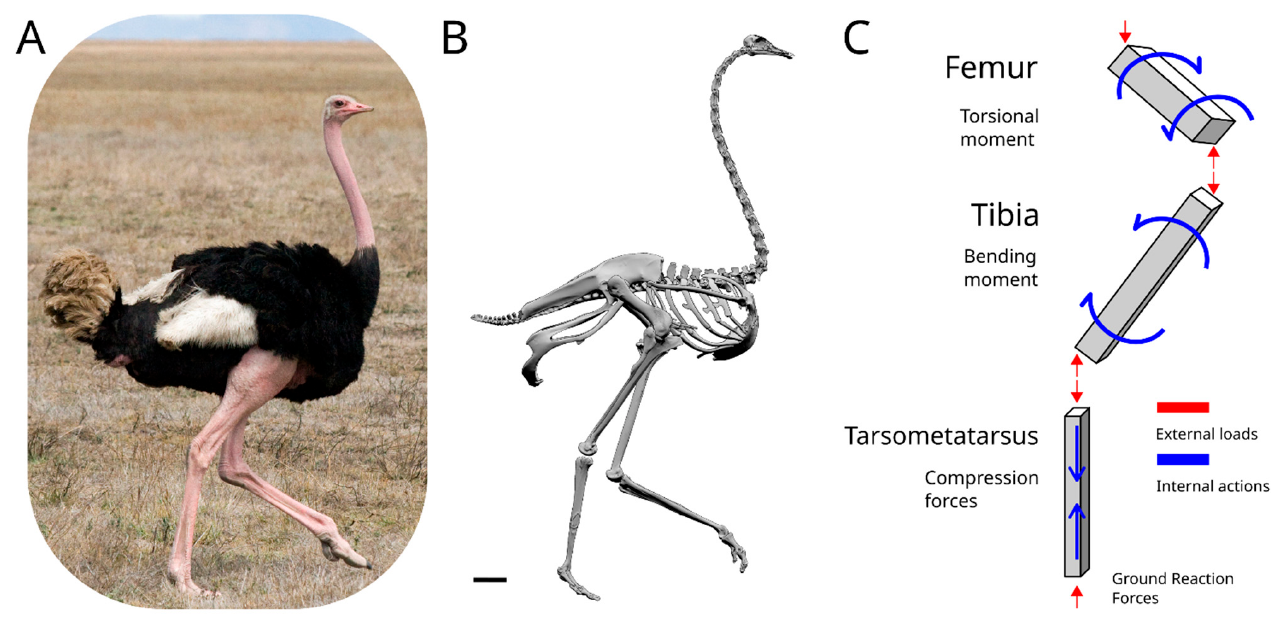
Figure 1. Scheme of the acting forces on a running ostrich. ( A ) Photo of an ostrich, courtesy of Mr. Stig Nygaard. ( B ) 3D model of an ostrich, courtesy of the Idaho Virtualization Laboratory. The scale bar is equal to 10 cm. ( C ) Simplified model of a standing ostrich leg. The elements are simplified in beams, with the distribution and direction of the external forces acting on each element illustrated in red, while the simplified and most important internal actions of each bone are represented in blue.